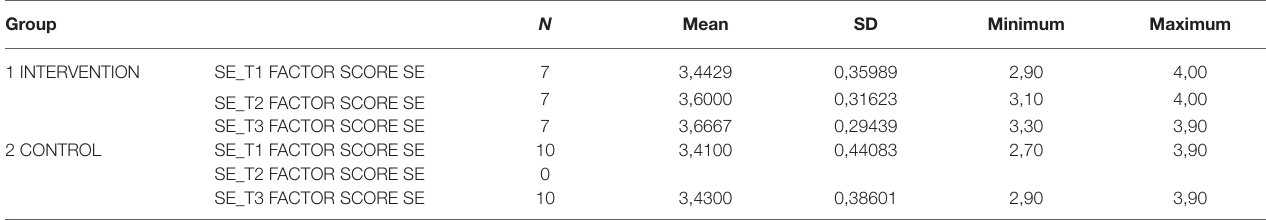
TABLE 8 | Intervention and Control Descriptive Statistics.